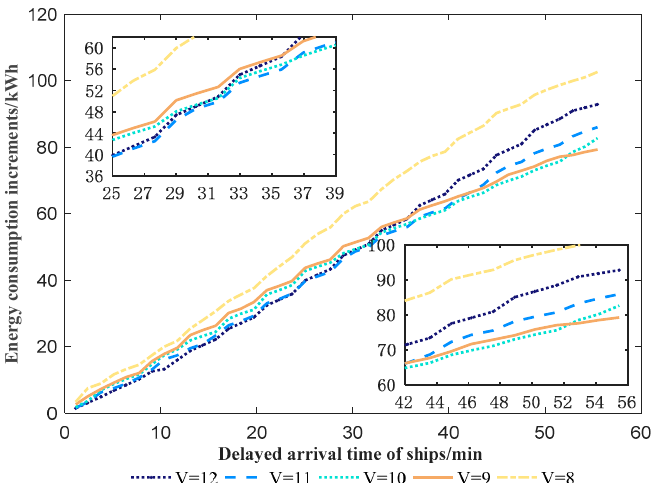
Figure 12. Variation in energy consumption for different ship delay times and number of AGVs.